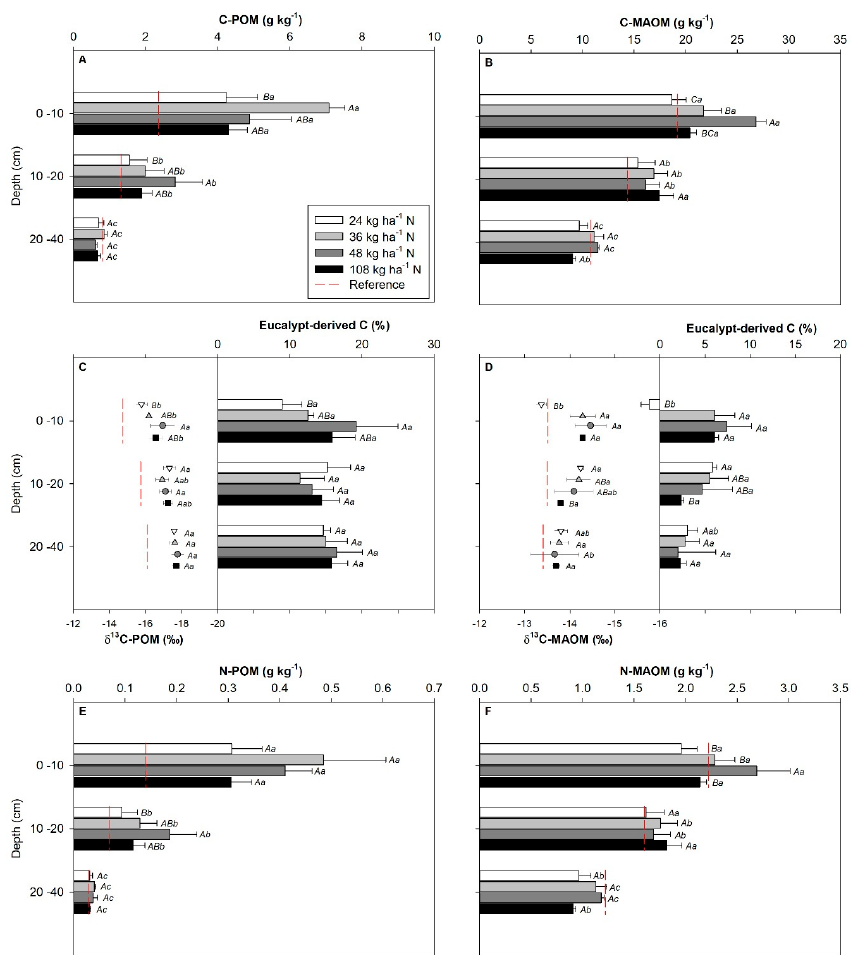
Figure 5. N fertilization effects on C (g kg − 1 , ( A , B )), δ 13 C (‰, bottom x axis) and eucalypt-derived C